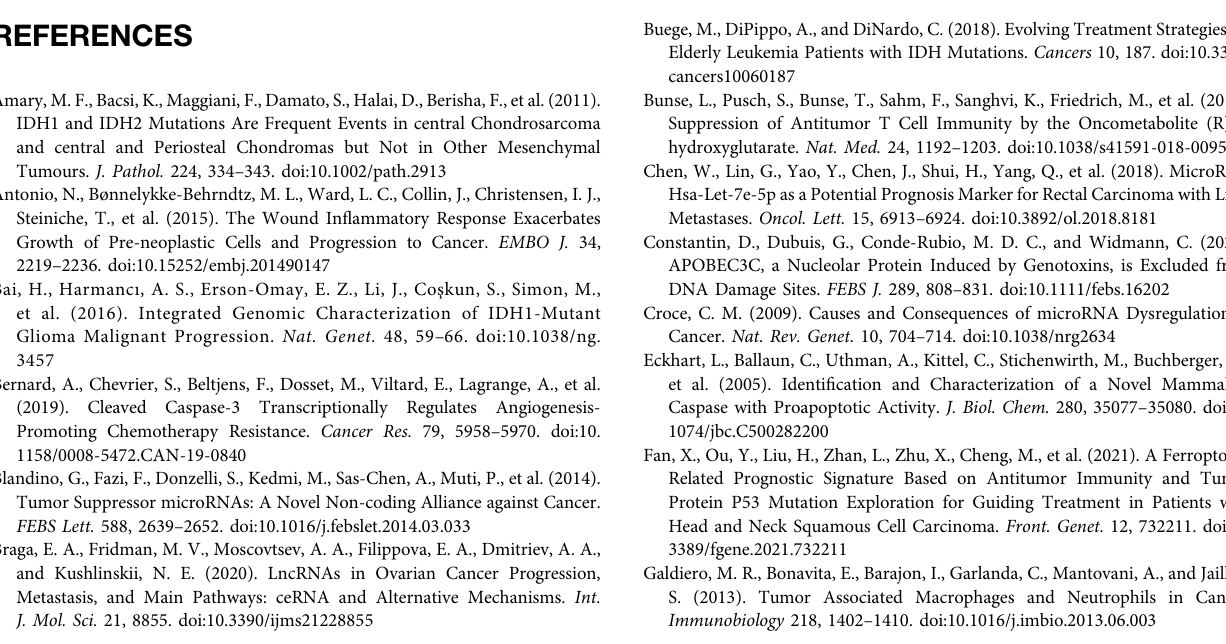
red/black/green dots represent up-regulated genes/genes with no signi fi cant difference/down-regulated genes, respectively. Supplementary Figure S4 | PR-DE-IRGs shared by the TCGA, CGGA, GSE4412, and GSE43378 cohorts. (A) Venn diagram showing the overlapping process of PR- DE-IRGs from 4 cohorts. (B – D) Forest plot showing the univariate Cox regression analysis results of 15 PR-DE-IRGs from CGGA, GSE4412, and GSE43378 cohorts, respectively. Supplementary Figure S5 | Survival curves of 15 PR-DE-IRGs from the CGGA cohort. Supplementary Figure S6 | Survival curves of 15 PR-DE-IRGs from the GSE4412 cohort. SupplementaryFigureS7| Survivalcurvesof15PR-DE-IRGsfromtheGSE43378 cohort. Supplementary Figure S8 | The process of determining 5 PR-DE-IRGs and corresponding coef fi cients based on the optimal penalty parameter ( λ ) via Lasso regression. (A) Thepenaltycoef fi cientwasutilizedtominimizethemeansquareerror of the model. (B) LASSO regression model pro fi le for the 5 selected PR-DE-IRGs. SupplementaryFigureS9| PCAandtSNEdotplotsbasedonthetraining,testing, whole, CGGA, GSE4412, and GSE43378 sets. Supplementary Figure S10 | Corresponding analysis results of 10 screened lncRNAs. (A – D) Correlation and difference analysis results of TUG1, LINC00689, NNT-AS1, and ZEB1-AS1 upstream of hsa-miR-365a-3p. (E , F) Correlation and difference analysis results of SNHG16 and AL590666.2 upstream of hsa-let-7e-5p. (G – J) Correlation and difference analysis results of PXN-AS1, ZEB1-AS1, TUG1, and NNT-AS1 upstream of hsa-miR-98-5p. (K) Kaplan-Meier survival curves of TUG1, LINC00689, NNT-AS1, ZEB1-AS1, SNHG16, AL590666.2, and PXN-AS1. Supplementary Figure S11 | Construction of the regulatory network consisting of circRNAs, miRNAs, and BMP2. (A) Obtaining common miRNAs by Venn diagram. (B , C) Differential expressionresults ofhsa-miR-129-5p andhsa-miR-381-3p based on GSE138764 set and TCGA set, respectively. (D , E) Kaplan-Meier survival curves for hsa-miR-129-5p and hsa-miR-381-3p based on the TCGA set, respectively. (F , G) Obtaining common circRNAs from 269 DE-circRNAs of the GSE165926 set and 6618/3647circRNAsupstreamofhsa-miR-129-5p/hsa-miR-381-3p predicted bystarBase,respectively. (H) Differentialexpressionresultsof12commoncircRNAs based on GSE165926 set. (I) The regulatory network consisting of hsa_circ_0004662/hsa_circ_0007548, hsa-miR-129-5p and BMP2. * p < 0.05; ** p < 0.01; *** p <